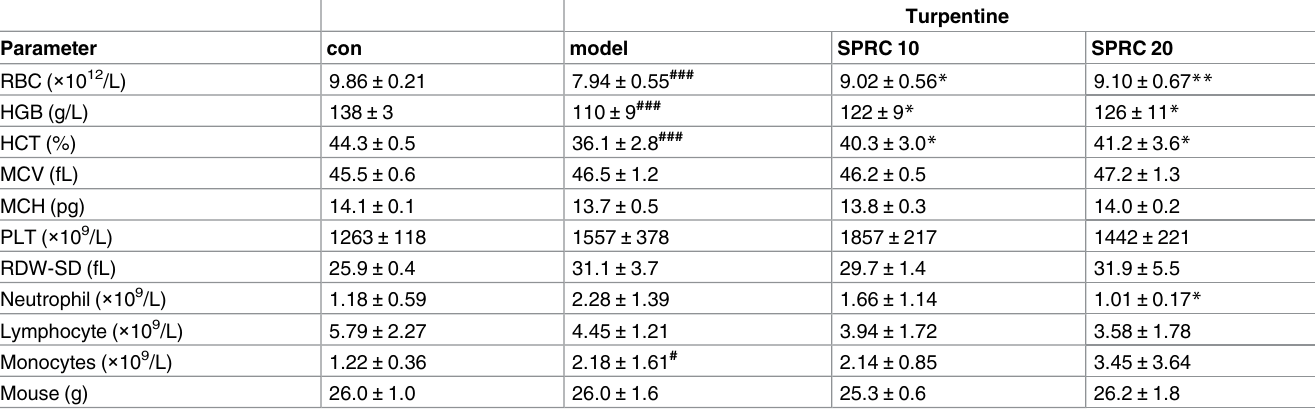
Table 1. Hematological and mouse